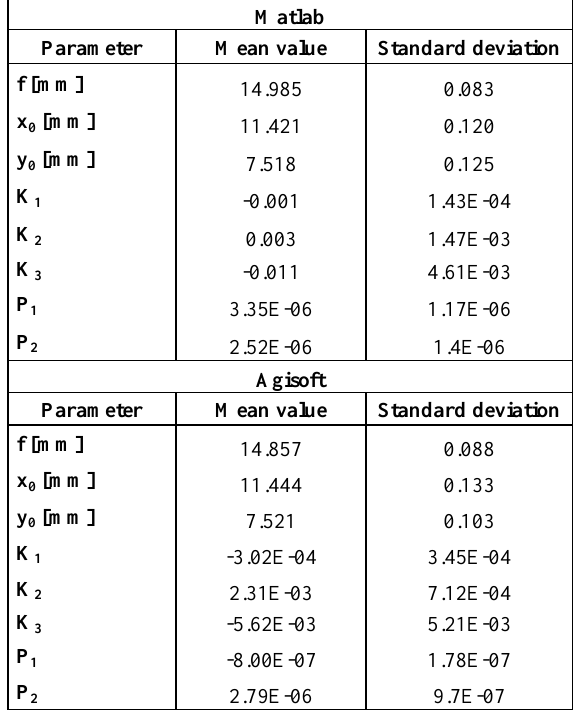
Table 3. The results of Sony NEX 5R calibration (Matlab and